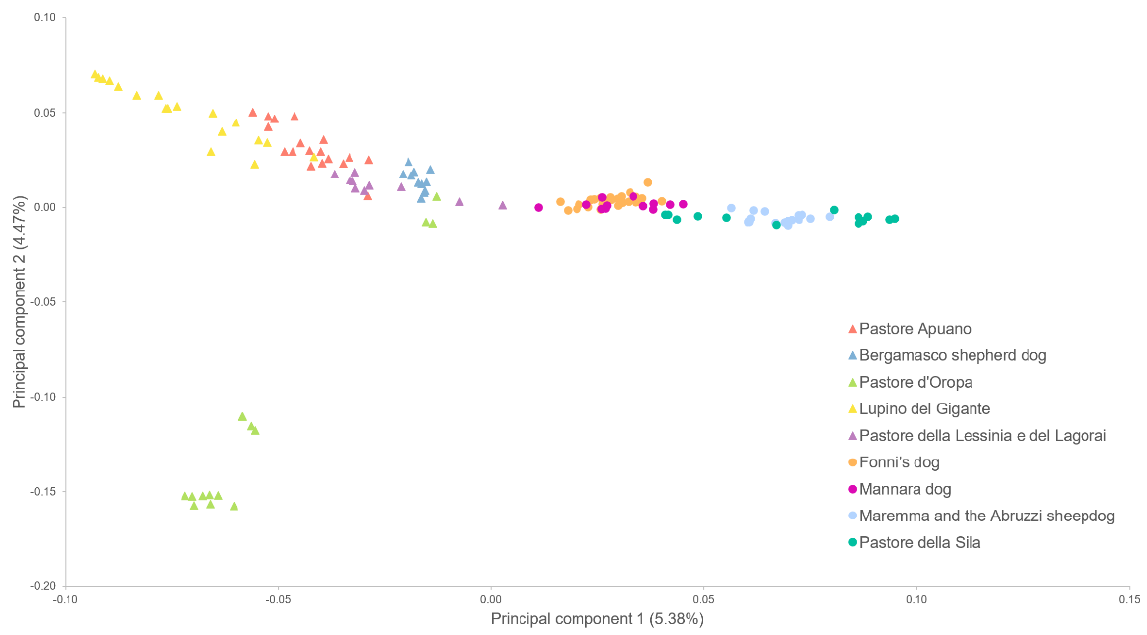
Figure 1. Multidimensional scaling plot representing the first and second principal components. Herding shepherd dogs are represented with diamonds, whereas livestock guardians are repre- sented with circles; each colour indicates a different breed.